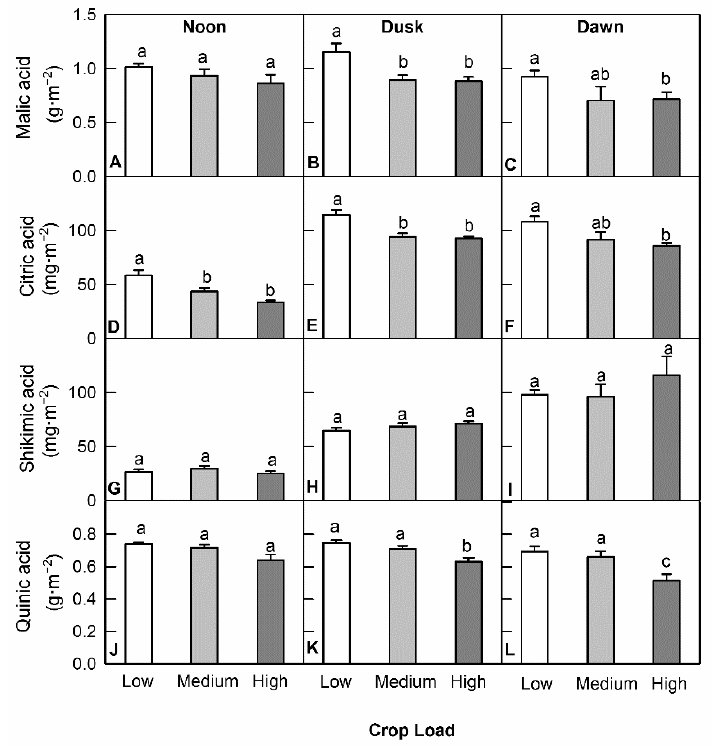
Figure 6. Effects of crop load on the concentrations of organic acids at noon, dusk, and dawn in apple leaves: malic acid ( A , B and C ), citric acid ( D , E and F ), shikimic acid ( G , H and I ), and leaves: malic acid ( A – C ), citric acid ( D – F ), shikimic acid ( G – I ), and quinic acid ( J – L ). Each bar is quinic acid ( J , K and L ). Each bar is mean ± SE ( n = 6). Different letters above the bars indicate a mean ± SE ( n = 6). Different letters above the bars indicate a significant difference for Tukey’s HSD significant difference for Tukey’s HSD test at p < 0.05. test at p <